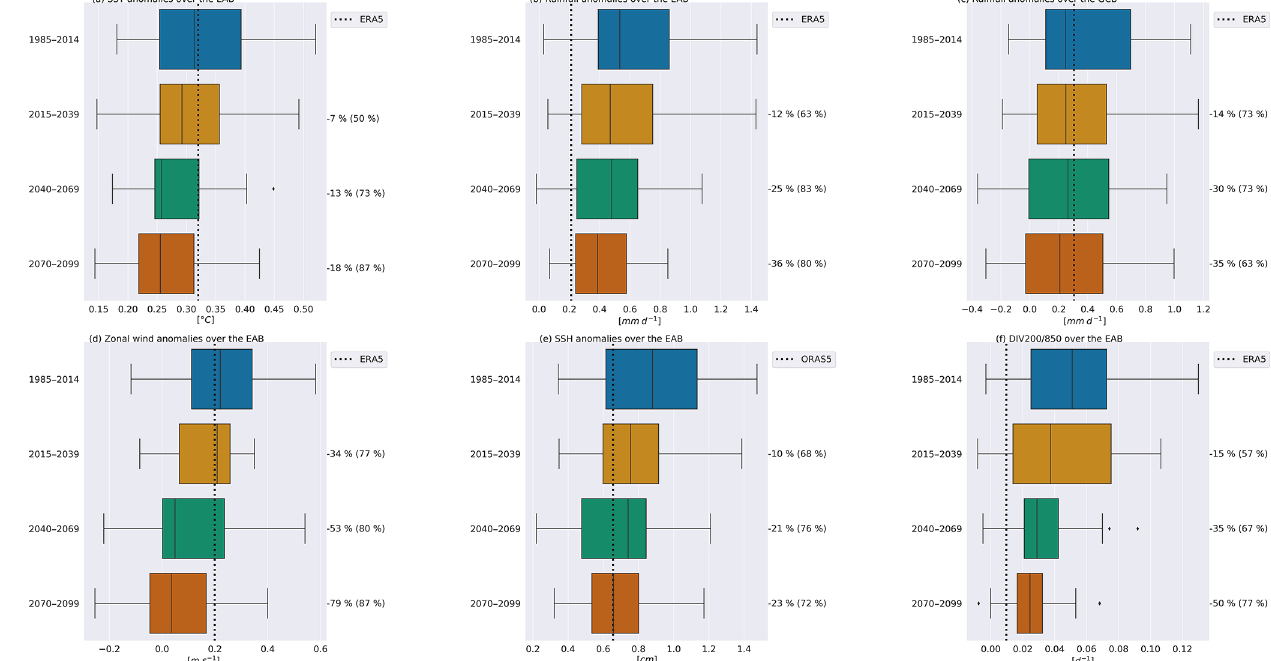
Figure 8. Boxplots of the JAS regression coefficients of (a) SST, (b) rainfall, (d) 850hPa zonal wind, (e) sea surface height and (f) horizontal wind divergence difference between 200 and 850hPa (DIV200 / 850) anomalies averaged over the equatorial Atlantic box. Boxplot of the regression coefficients of the rainfall anomalies averaged over the Guinea Coast (c) . The variables from each of the 30 models are regressed onto the standardized JAS ATL3 SST index, for four different periods: 1985–2014, 2015–2039, 2040–2069 and 2070–2099. Each boxplot represents the distribution of the 30 regression coefficients averaged over the specified area in the different models. Vertical lines represent the corresponding regression values in ERA5 (ORAS5) for the 1985–2014